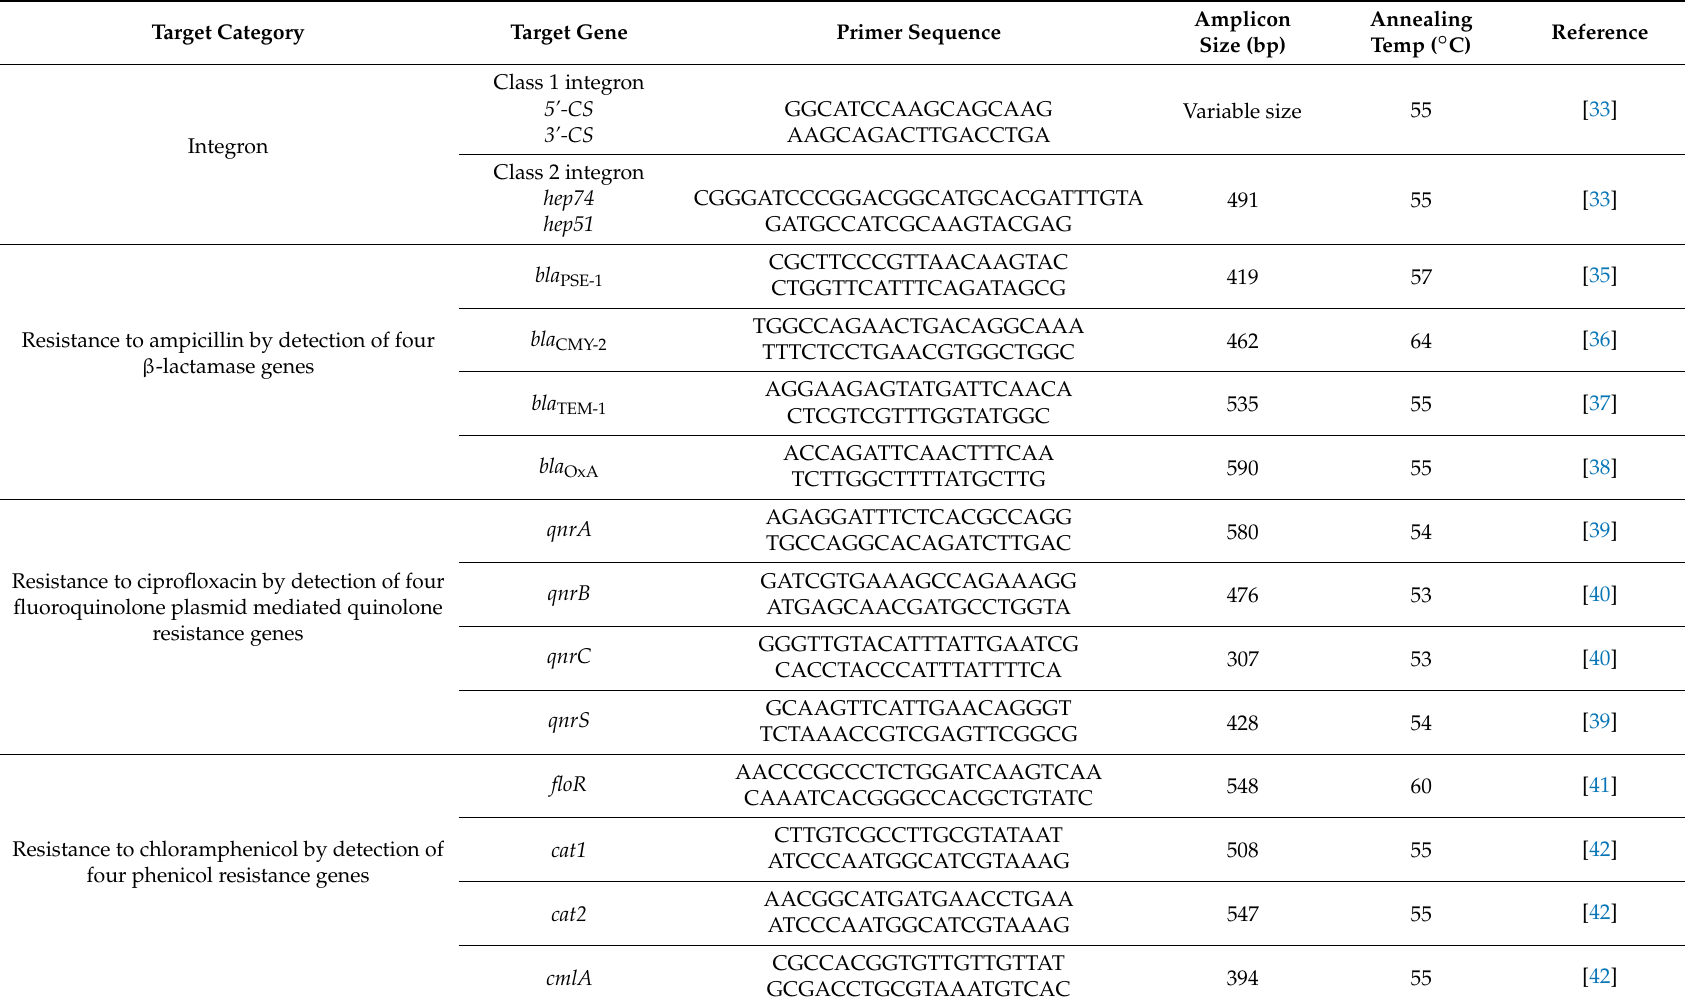
Table 1. PCR primers used for amplification of genes encoding integrons and antimicrobial resistance in non-typhoidal Salmonella